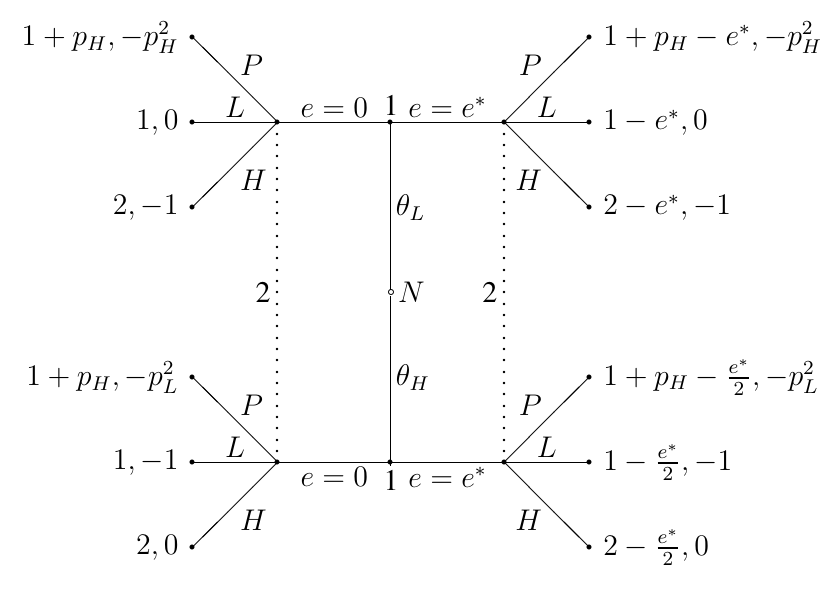
Figure 1. The extensive form representation of Spence’s game in which workers choose from only two levels of education and employers either act as though senders are pooling ( P ) or act as though the message indicates low quality ( L ) or act as though the message indicates high quality ( H